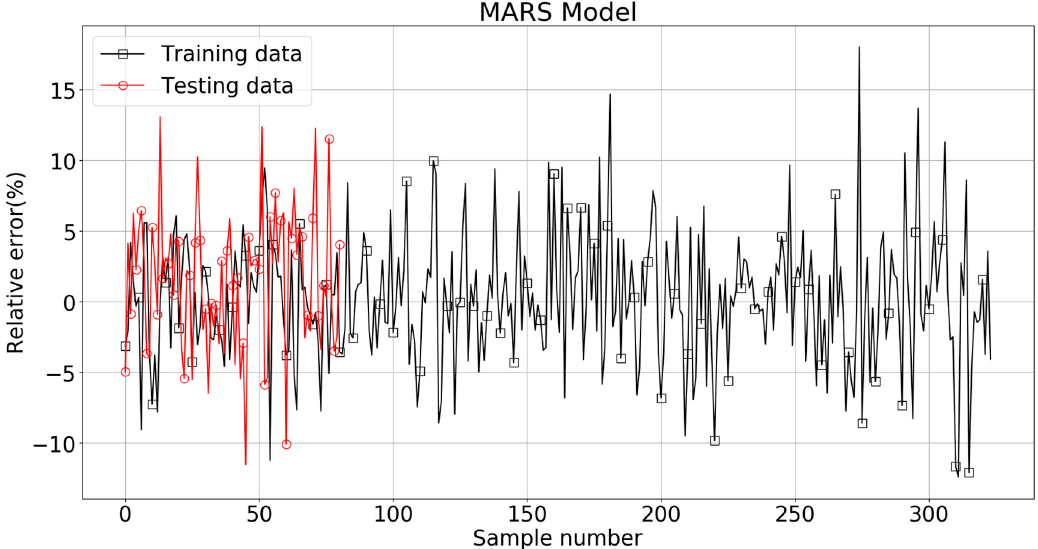
Figure 31. Variation of the relative errors obtained from the MARS model.